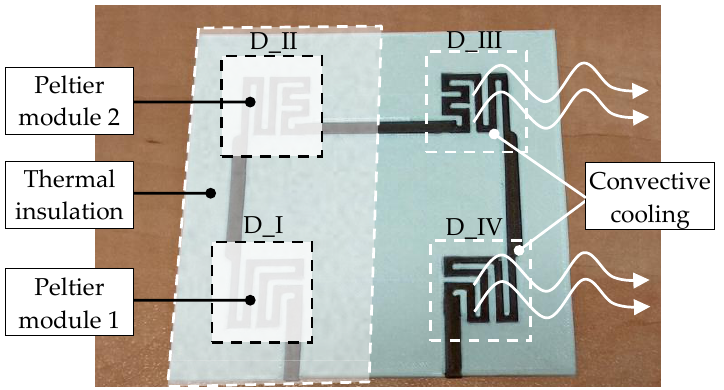
Figure 10. The configuration to determine an average temperature of a four–sensor device.